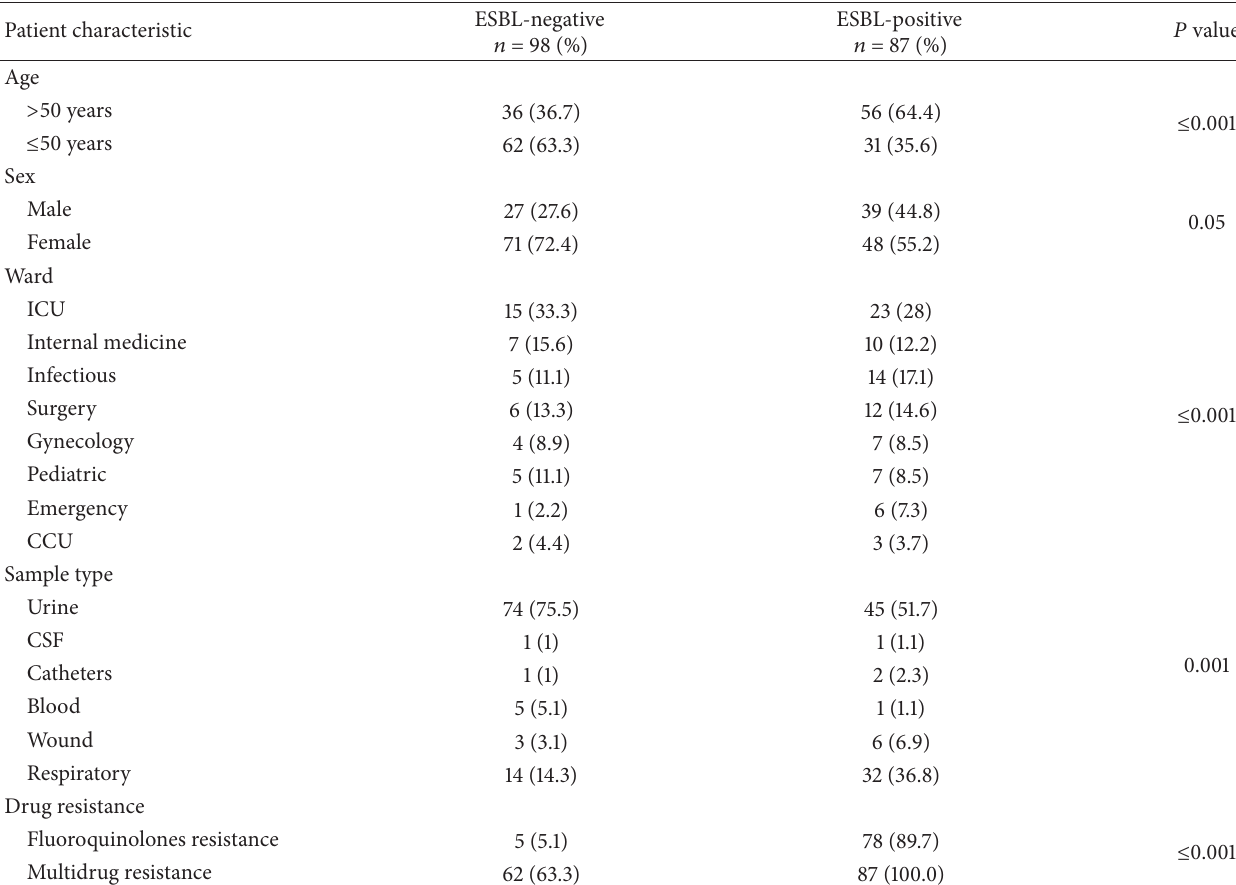
Table 3: Association between patient characteristics and acquisition of extended-spectrum 𝛽 -lactamase-producing Klebsiella pneumoniae